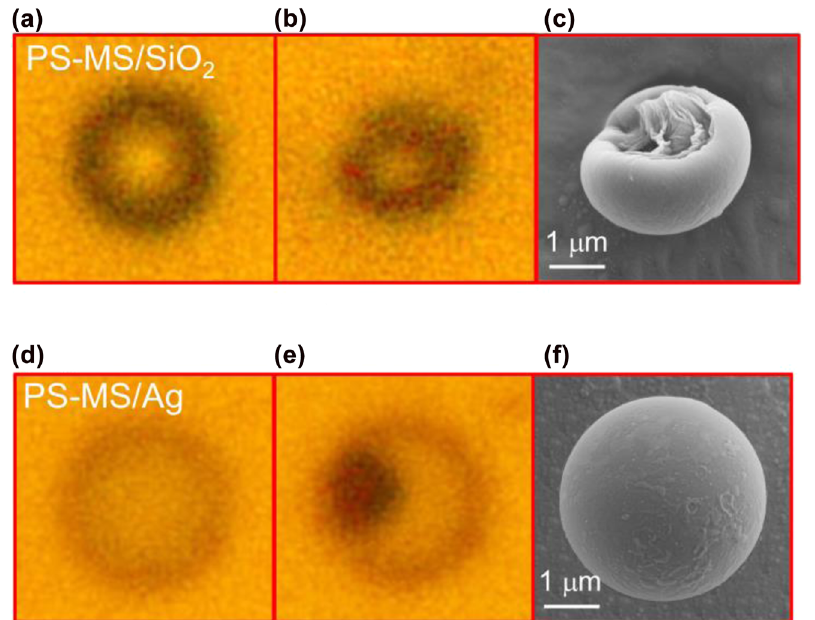
microcavity before (a) and after (b) laser irradiation. (c) SEM image of the PS-MS/SiO Figure 3: Bright-field images of the PS-MS/SiO 2 microcavity after laser irradiation. The bright-field images of the PS-MS/Ag microcavity before and after laser irradiation are shown in (d) and (e). (f) SEM image of the PS-MS/Ag microcavity after laser